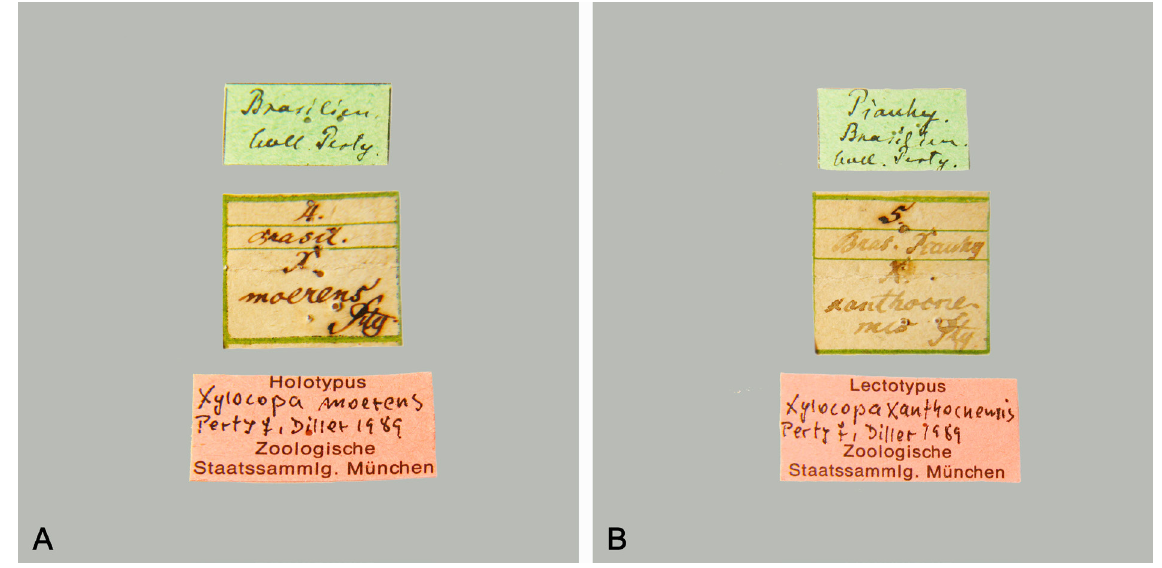
Fig. 5. Data labels. A . Xylocopa moerens Perty, 1833 (lectotype ♀︎). B . Xylocopa xanthocnemis Perty, 1833 (lectotype